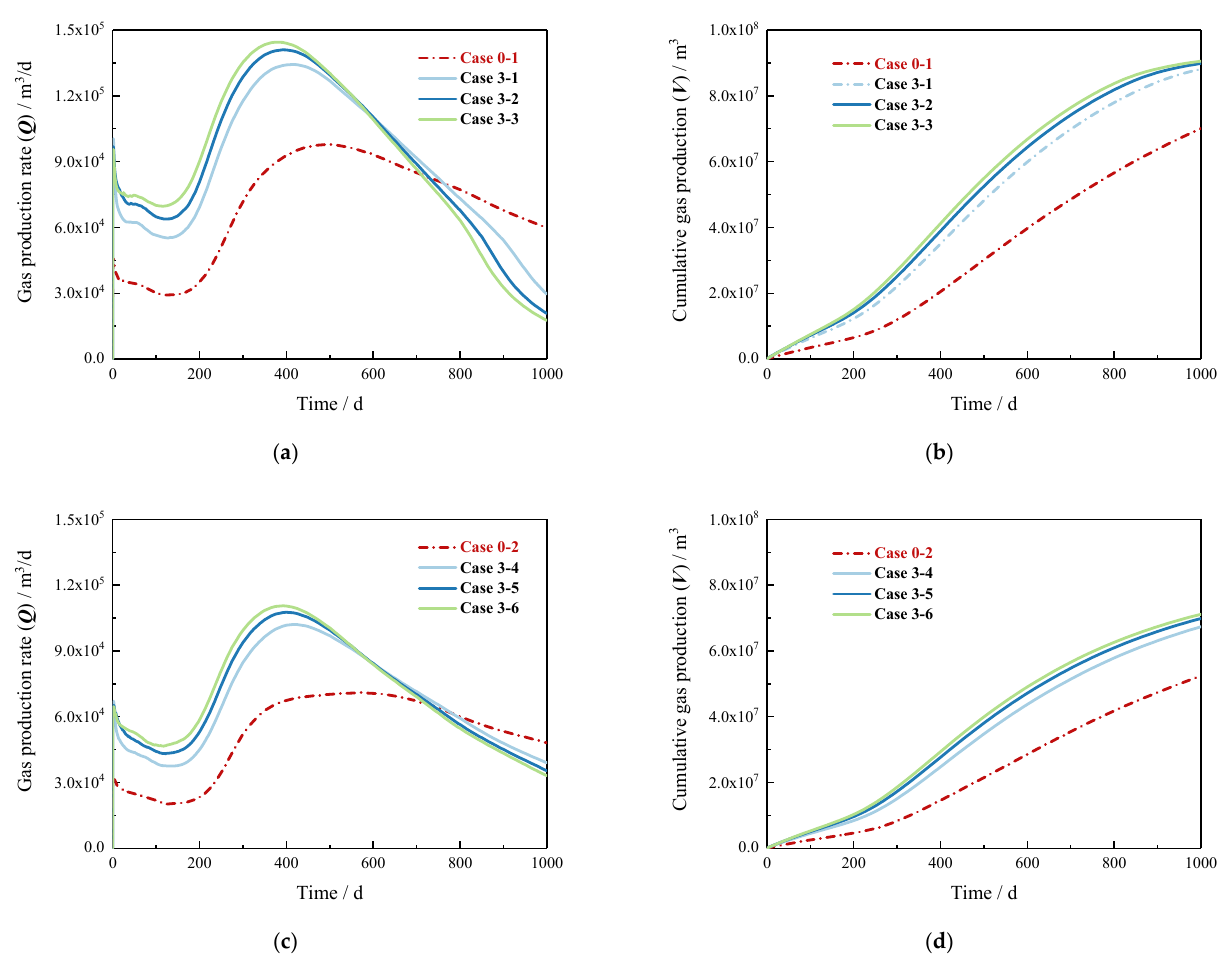
Figure 10. Gas production characteristics for the clustered depressurization: ( a ) gas production rate (1 MPa); ( b ) cumulative gas production (1 MPa); ( c ) gas production rate (4 MPa); and ( d ) cumulative gas production (4 MPa).